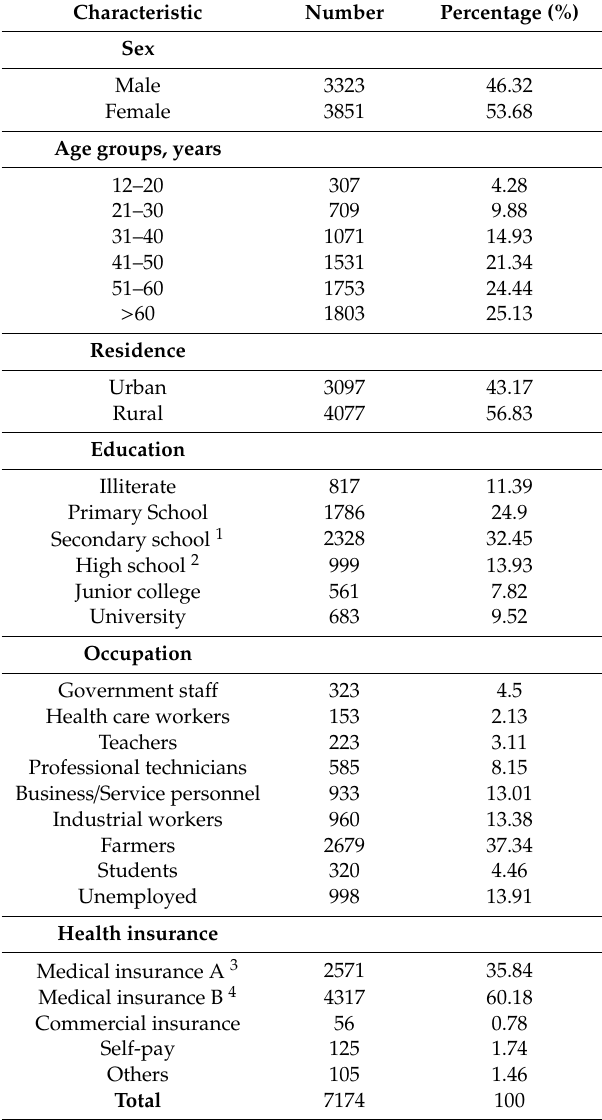
Characteristic Number Percentage